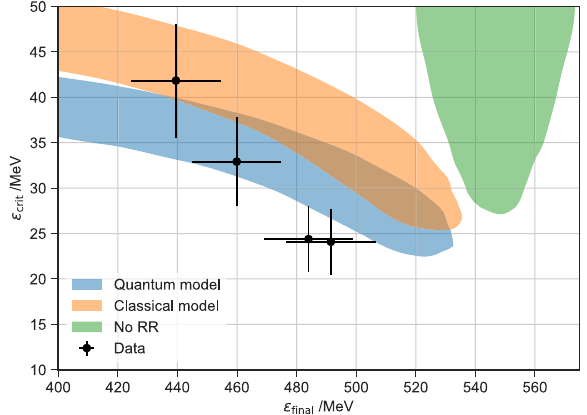
FIG. 9. Experimentally measured ε as a function of ε crit final measured at the electron spectral feature (points). The shaded areas correspond to the results a hypothetical ensemble of identical experiments would measure 68% of the time under different assumed radiation reaction models for a uniform distribution of a 0 between 4 and